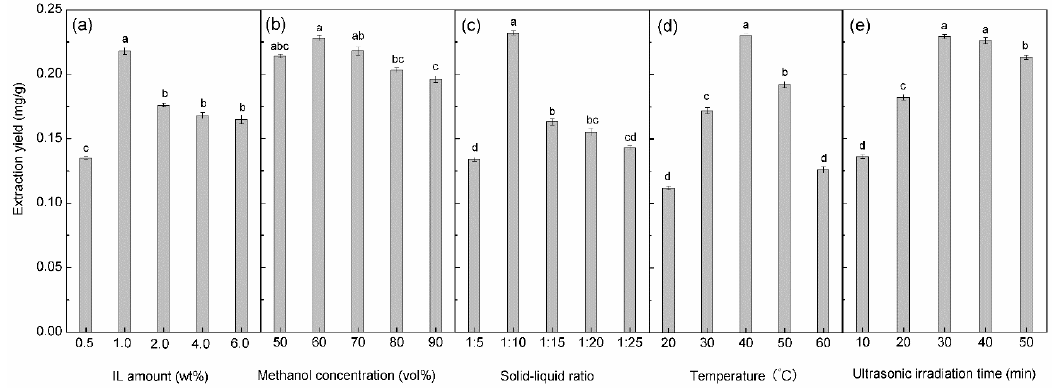
Figure 2. Effect of different factors to the extraction yield of paclitaxel in the single factor experiments. ( a ) the IL amount (0.5 g T. x media leaves powder, 60 vol % methanol, 1:10 solid–liquid ratio, 40 ◦ C extraction temperature, and 30 min extraction time); ( b ) Methanol concentration (0.5 g T. x media leaves powder, 1.0 wt % IL, 1:10 solid–liquid ratio, 40 ◦ C extraction temperature, and 30 min ultrasonic irradiation time); ( c ) Solid–liquid ratio (0.5 g T. x media leaves powder, 60 vol % methanol, 1.0 wt % IL, 40 ◦ C extraction temperature, and 30 min ultrasonic irradiation time); ( d ) Extraction